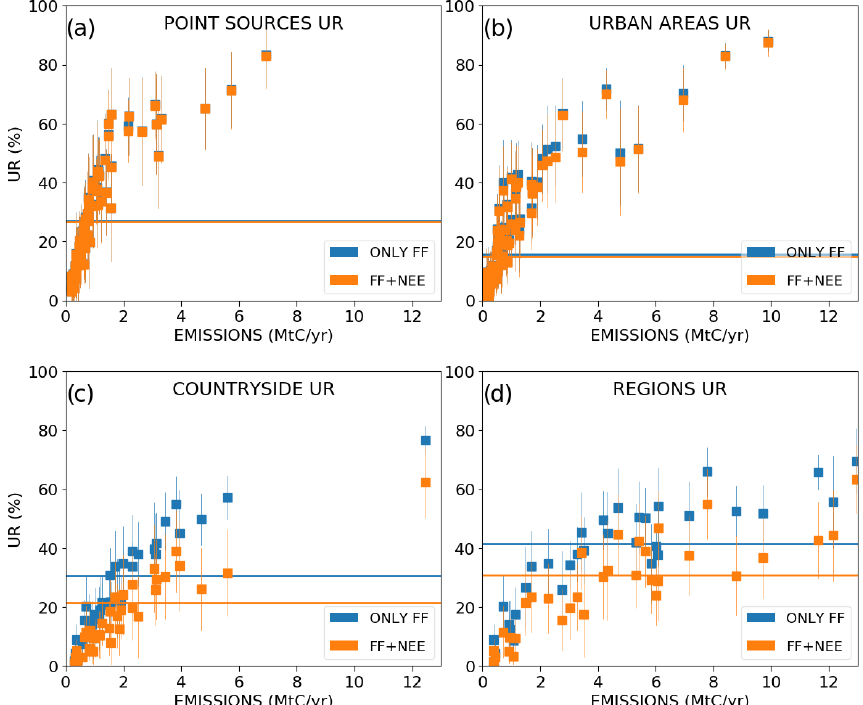
Figure 9. Same as Fig. 7 but the results are derived from inversions considering the anthropogenic emissions only (blue markers) and from inversions considering the natural fluxes as well (orange markers). Prior uncertainties on the 6h budgets of the point sources, urban and countryside areas are taken to be equal to 50%, and prior error correlations between hourly emissions have a temporal length of 3h. Prior uncertainties on the regional budgets are then derived by aggregation of the prior uncertainties of their constituent emitting sources (mean value ∼